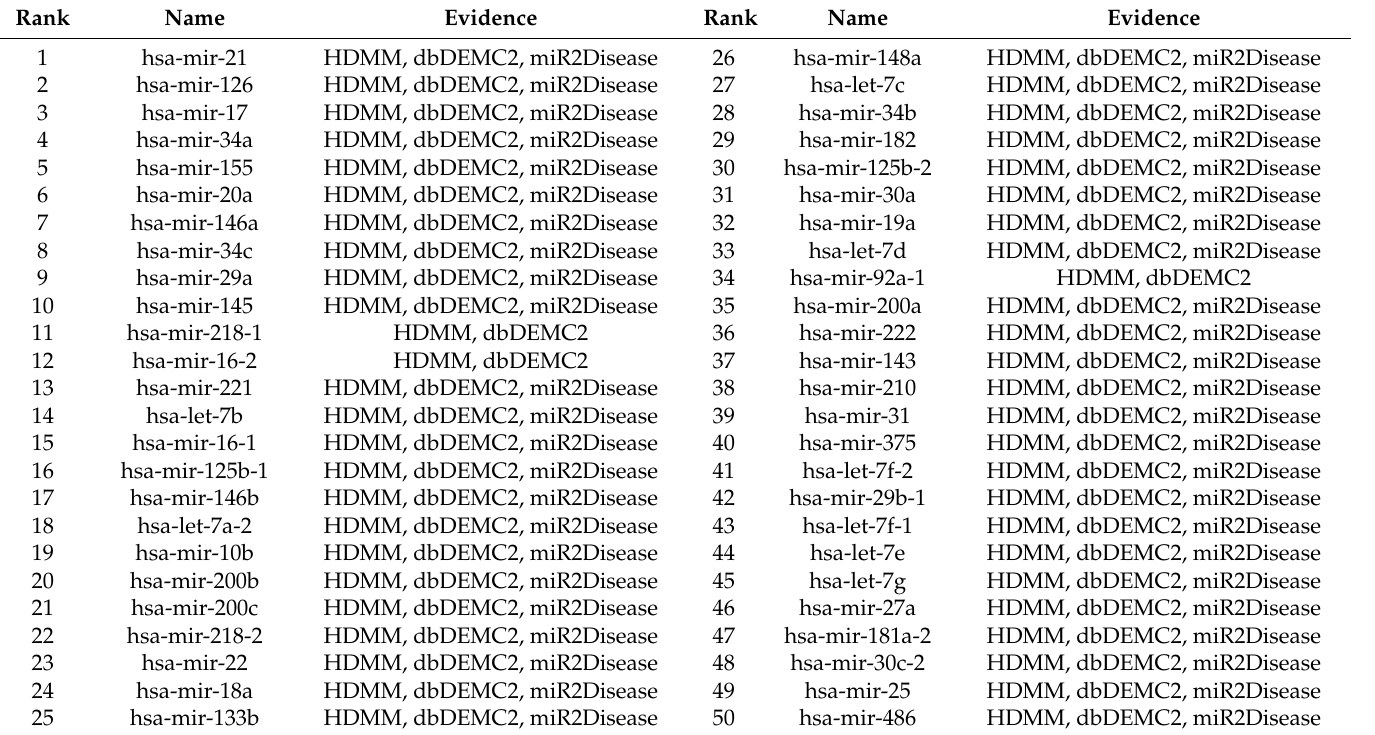
Table 3. The top 50 breast neoplasms-related